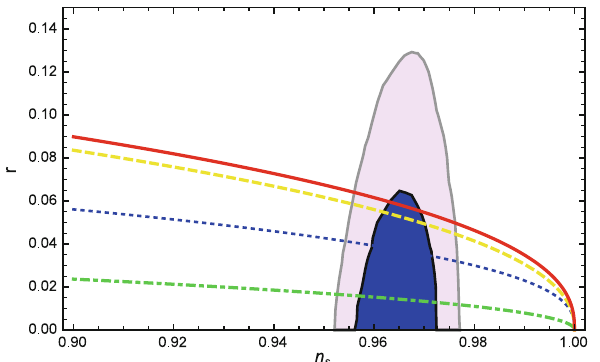
Fig. 1 1 σ and2 σ confidenceregionsborrowedfromPlanck[47], r – n s trajectories of the present model. The solid red , dashed yellow , dotted blue and dot-ashed green lines correspond to the combinations ( 29 . 4 × 10 − 12 ) , ( 39 × 10 − 15 ) , ( 19 . 3 × 10 − 6 ) and ( 49 . 5 × 10 − 4 ) of (λ, A ) . There is no transition from n s < 1 to n s > 1